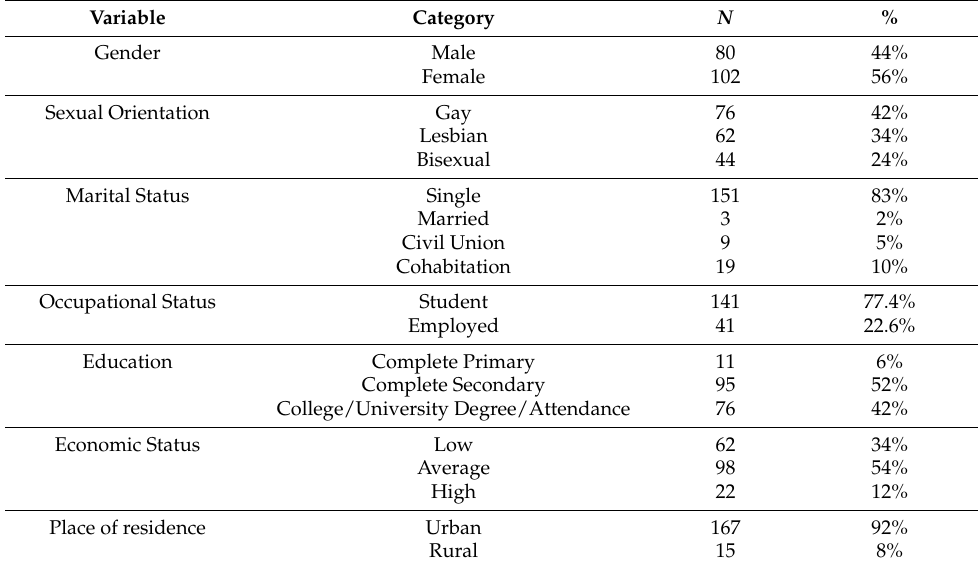
Table 1. Sociodemographic Characteristics ( N =